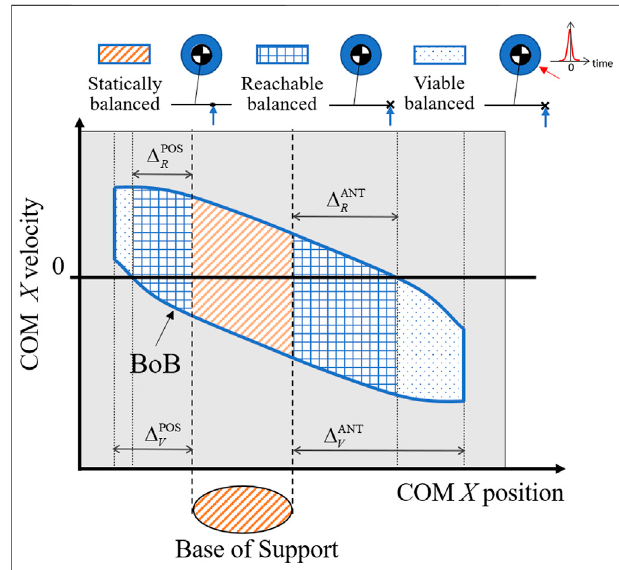
FIGURE 2 | The reachable and viable boundary margins in both the anterior (ANT) and posterior (POS) directions divide the balanced region into three partitions, each identifying a type of balanced states: statically, reachable, and viable balanced states. For each type of balanced state, an illustration of the corresponding balance control strategy is shown using a simple legged system with a point mass, fl ywheel, and foot link.